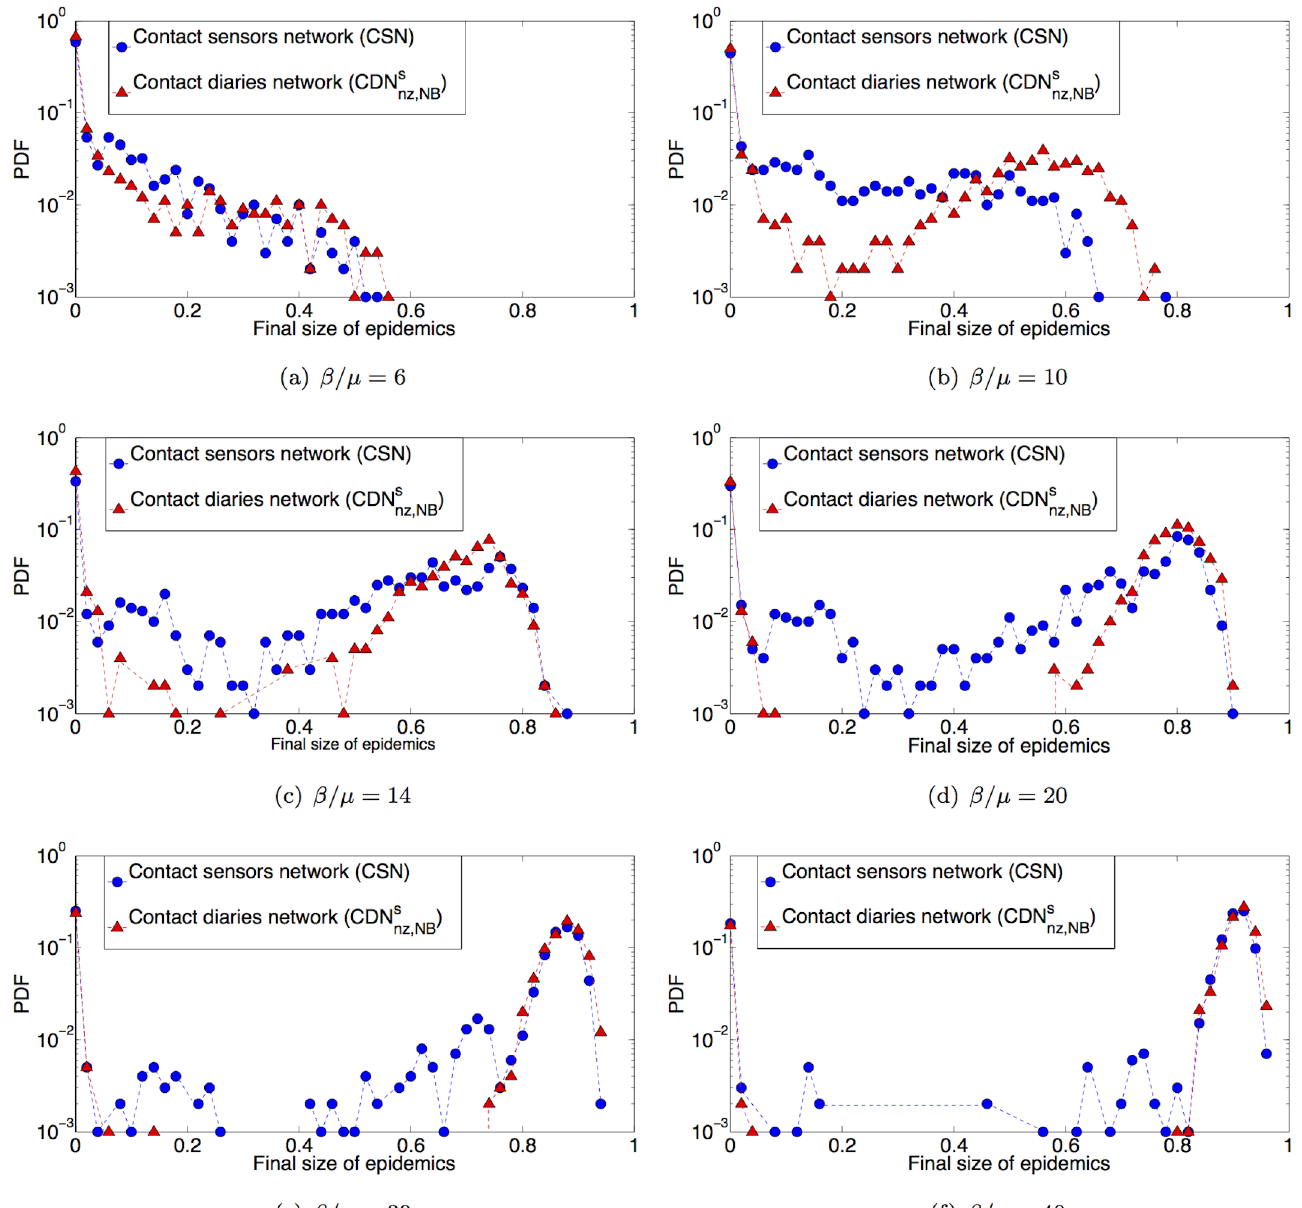
Fig 7. Outcome of the spreading processes. Comparison of the distributions of epidemic sizes obtained for 1000 SIR simulations performed on the contact sensors network and on the surrogate contact network with weights randomly drawn from a negative binomial fit of the distribution of contact ). Each process starts with one random infected seed. (a) β / μ = 6, (b) β / μ = 10, (c) durations registered by sensors in several environments (CDN s nz ; NB β / μ = 14, (d) β / μ = 20, (e) β / μ = 30, (f) β / μ =